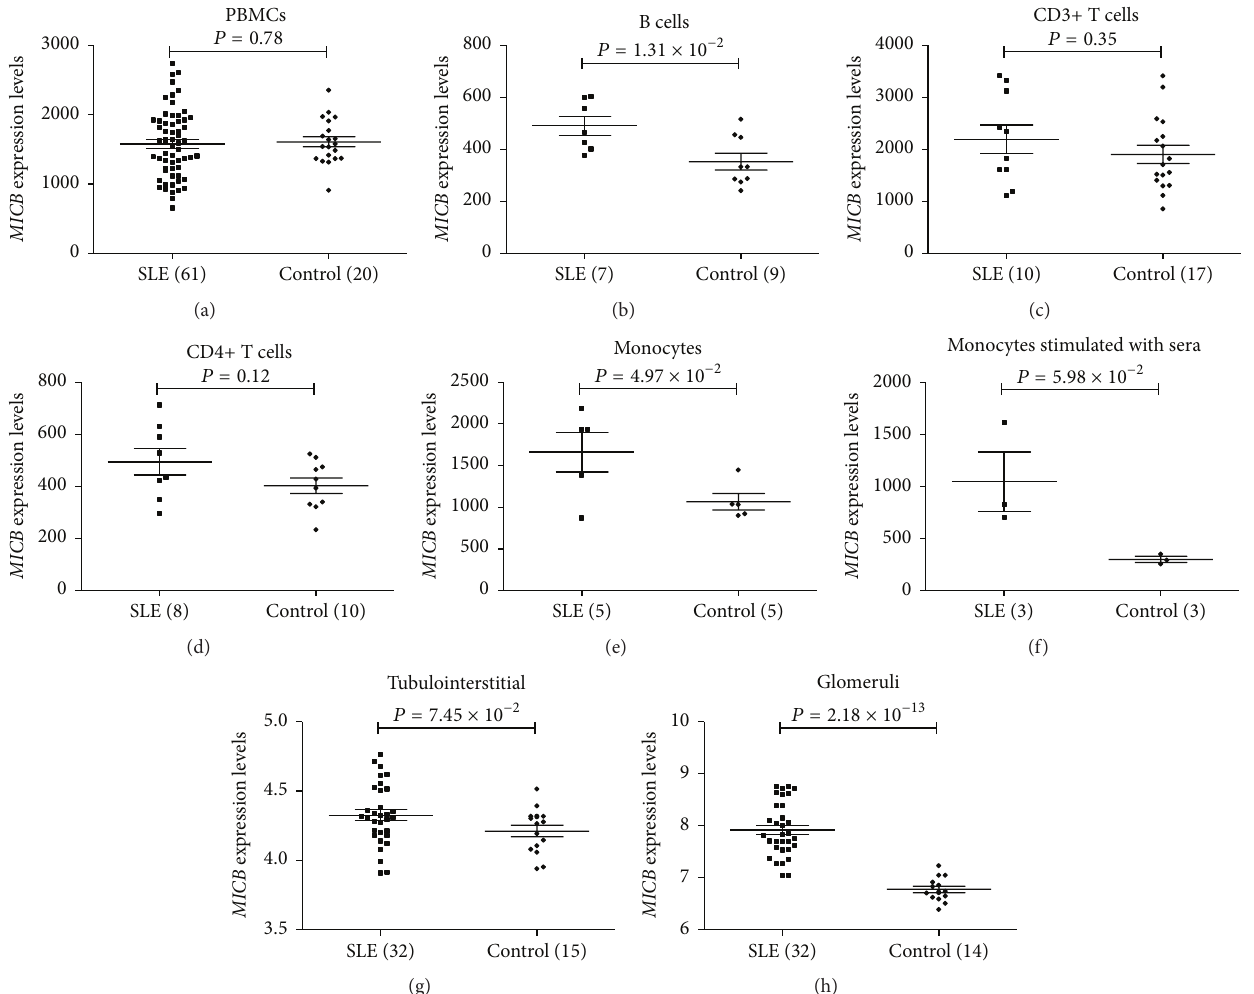
Figure 2: Gene differential expression analyses of MICB in immune cell subsets and renal biopsies from SLE patients and controls. (a)–(h) present the MICB expression levels in immune cell subsets and renal biopsy samples from SLE patients and normal donor controls. MICB mRNAexpressionwassignificantlyormarginallysignificantlyupregulatedinSLEBcells(489.80 ± 95.50versus352.66 ± 96.13; 𝑃 = 1.31×10 −2 ; (b)), monocytes (1661.14 ± 532.87 versus 1065.38 ± 220.72; 𝑃 = 4.97 × 10 −2 ; (e)), tubulointerstitial samples (4.33 ± 0.22 versus 4.21 ± 0.16; 𝑃 = 7.45 × 10 −2 ; (g)), and glomeruli samples (7.92 ± 0.52 versus 6.77 ± 0.23; 𝑃 = 2.18 × 10 −13 ; (h)). Although with a rather small sample size, a marginally significantly higher expression level of MICB has been observed in monocytes from healthy donors incubated with SLE sera compared to those incubated with autologous serum (1047.50 ± 494.43 versus 300.40 ± 48.88; 𝑃 = 5.98 × 10 −2 ; (f)), while there was no difference of MICB mRNA expression in PBMC (1577.45 ± 488.74 versus 1610.67 ± 325.23; 𝑃 = 0.78 ; (a)), CD3+ T cells (2195.09 ± 865.77 versus 1900.54 ± 715.70; 𝑃 = 0.35 ; (c)), and CD4+ T cells (495.56 ± 144.59 versus 401.59 ± 94.80; 𝑃 = 0.12 ; (d)). PBMCs: peripheral blood mononuclear cells; SLE: systemic lupus erythematosus. The expression data of MICB was captured from ArrayExpress Archive database